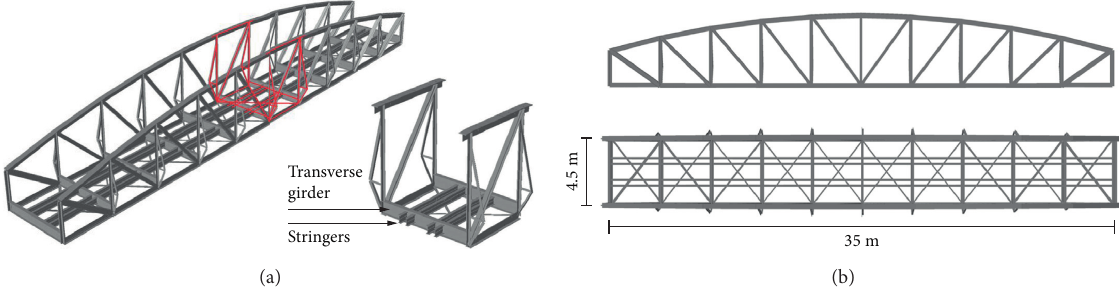
Figure 2: Simplified 3D model of the main structural steel in the Hell Bridge Test Arena. (a) 3D perspective view including a detailed bridge section. (b) Vertical wall (top) and plan view of the bridge deck